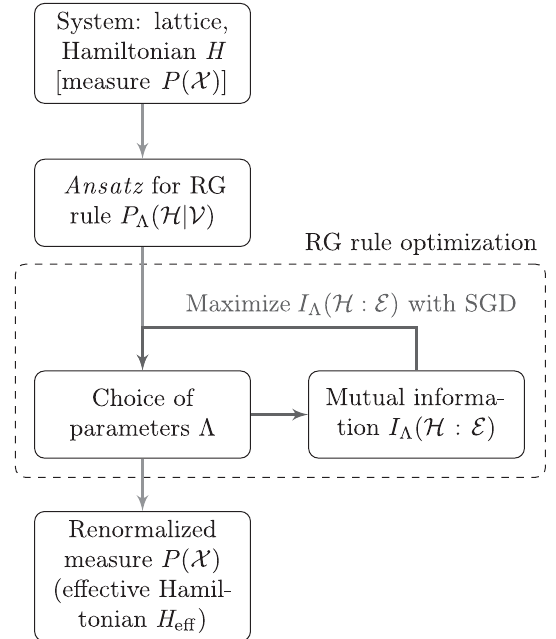
FIG. 1. Flow diagram of the RSMI algorithm [28]. Given a lattice and Hamiltonian H (or, in practice, given Monte Carlo samples) a RBM Ansatz for the RG rule is optimized by maximizing the mutual information between the new d.o.f. H and the environment E of the original ones using stochastic gradient descent. The trained P Λ ð H j V Þ is used to define a new effective measure and Hamiltonian H eff